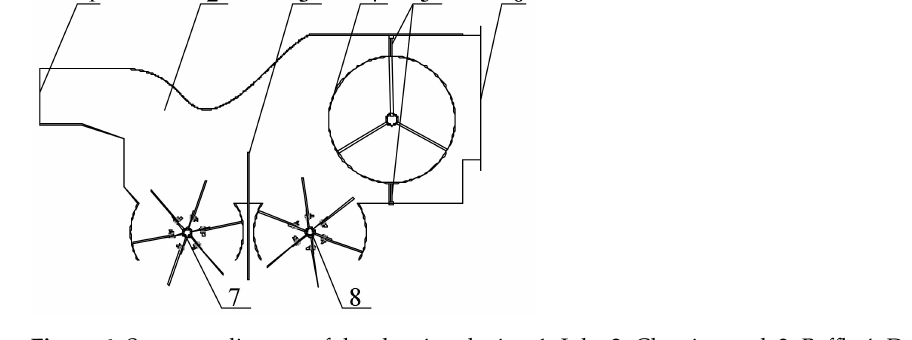
Figure 6. Structure diagram of the cleaning device. 1. Inlet 2. Cleaning tank 3. Baffle 4. Drum